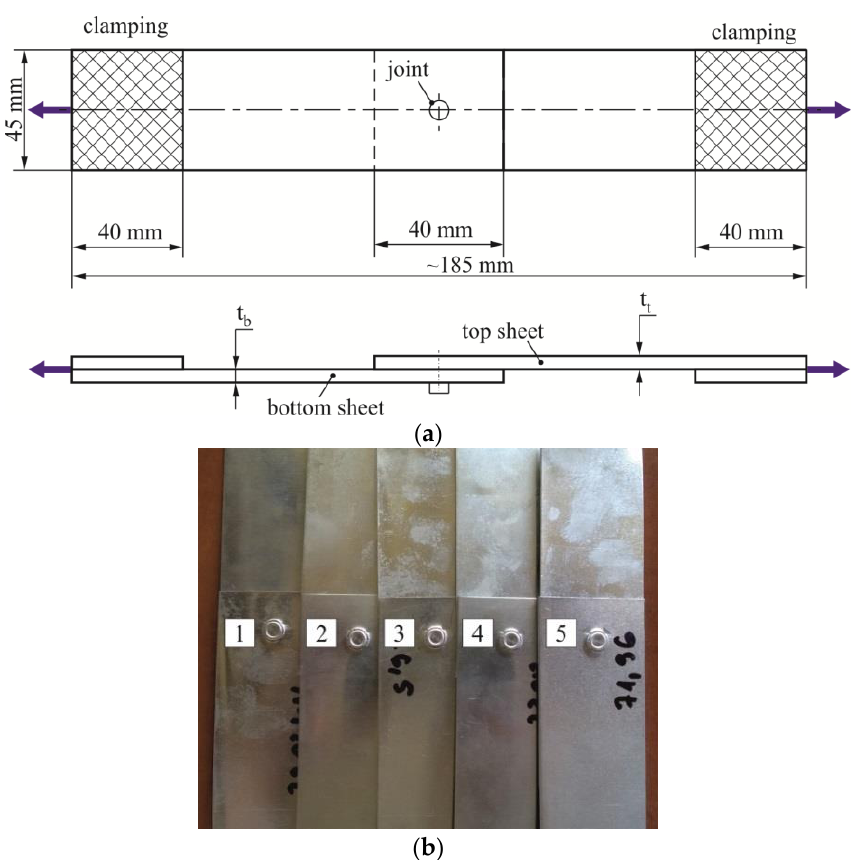
Figure 2. Single-lap tensile shear test specimens: ( a ) dimensions, ( b ) five samples for one sheet ar- Materials 2021 , 14 , x FOR PEER REVIEW rangement. arrangement.